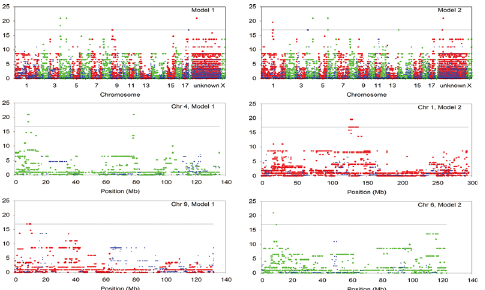
Fig 2. Manhattan plots showing the LRT values from the test of association of SNP mismatches with outcome of corneal transplantation assuming rejection Models 1 and 2. The two upper plots show values for the entire genome except the Y chromosome. For SNP mismatches associated with rejection, LRT values of adjacent chromosomes are distinguished by alternating red and green symbols. Blue symbols on all plots represent values for SNP mismatches associated with acceptance. Lower plots represent individual chromosomes in which there were blocks of 4 or more SNP mismatches associated with rejection. The horizontal line on each plot indicates the genome-wide significance LRT threshold obtained using permutation analysis